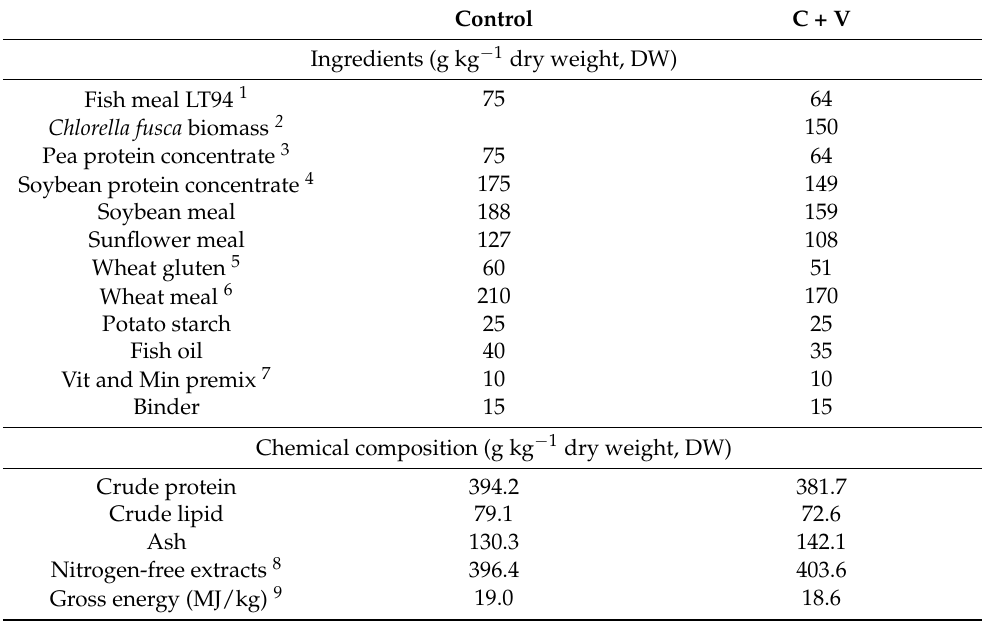
Table 1. Ingredient composition of the experimental diets. Control C +